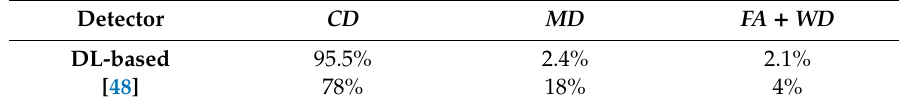
Table 4. Comparison between the detector proposed in this paper (DL-based) and a state-of-the-art approach [48], based on template matching and morphological filtering. FT3-A (381 images).